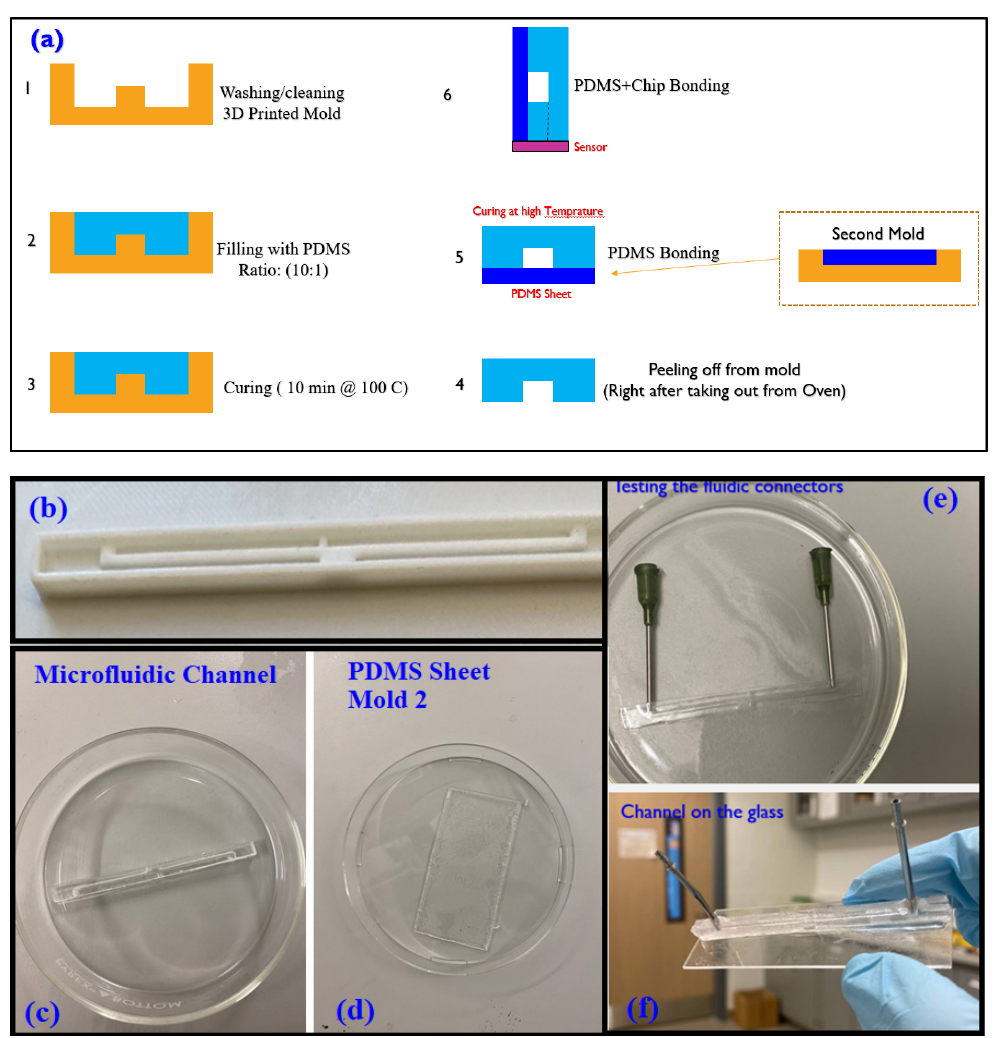
Figure 5. The processes led to the fabrication of a microfluidic channel on top of the sensor. ( a ): the PDMS replica molding process undertaken to create the 3D microfluidic with two 2D PDMS; ( 1 ) first the 3D printed mold was washed, ( 2 ) filling the mold with a 10:1 ration of pre ‐ prepared PDMS (after filling the mold, the PDMS and mold were put in the vacuum chamber for 20 mins for degassing), ( 3 ) after degassing, the PDMS and mold were put in the oven and baked for 5 min at 100 C, ( 4 ) the PDMS was peeled off from the mold, ( 5 ) at this point, a channel is put on a PDMS sheet, which has already been prepared with another mold, ( 6 ) bonding the PDMS and chip. ( b ): the used channel molds. ( c ) showing the peeled ‐ off microfluidic structure. ( d ): the PDMS sheet shown in step 5. ( e ) testing the fluidic connectors with water. ( f ) showing the adhesion of the PDMS channel on the glass.